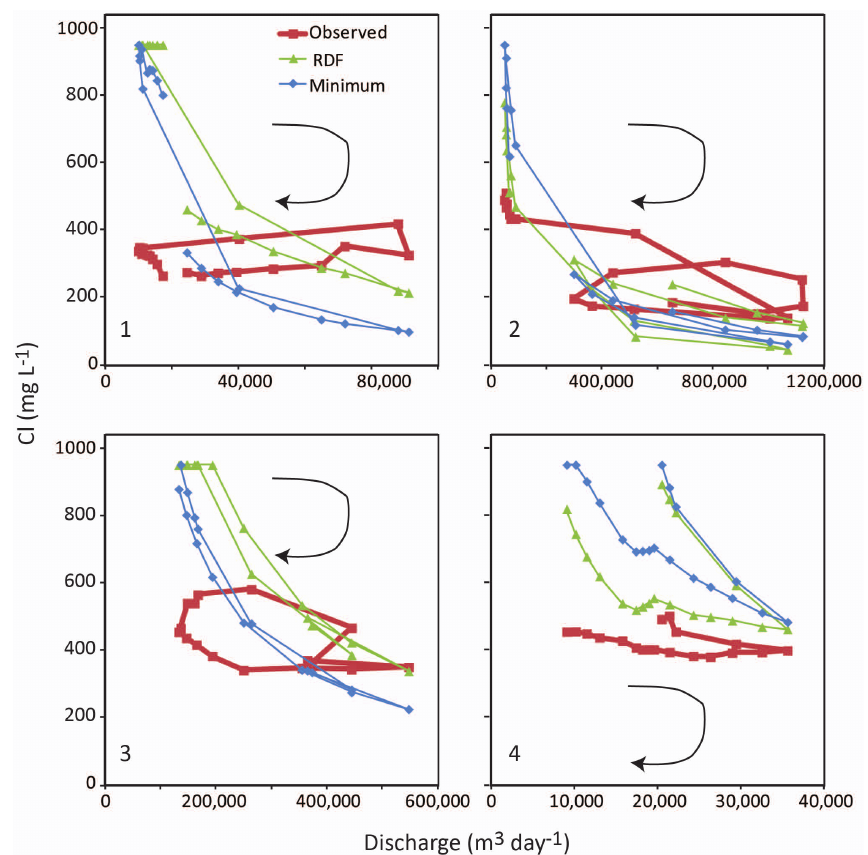
Fig. 8. Cl concentrations vs. discharge hysteresis loops for discharge events in 2002 at Winchelsea. Arrows show changes with time; numbers correspond to events on Fig. 4b. RDF and Min indicate the calculated Cl vs. discharge relationships made using the baseflow estimates from the Lyne and Hollock digital filter and the local minimum technique, respectively. These calculations assume that the analytical techniques yield estimates of the total baseflow to the river and that groundwater is the only component of baseflow. These calculations used a Cl concentration of 970mgL − 1 for groundwater and 23mgL − 1 for surface